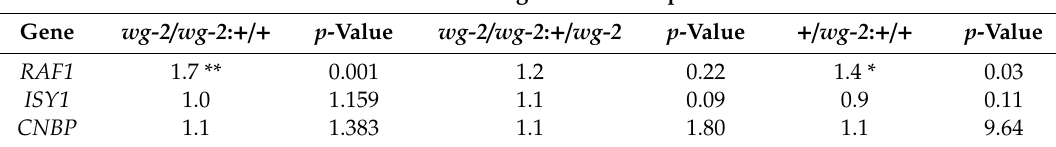
Table 4. Comparison among wg-2 genotypes of transcript expression for three genes in the linked 227-kb wg-2 region as determined by RT-qPCR indicates higher RAF1 transcript expression in mutant and carriers versus wild-type embryos. Three embryos per genotype ( n = 9 total) were analyzed for each gene and their expression compared to GAPDH at Stage 36 HH to determine the relative expression of target gene to housekeeping gene. Note that RAB43, EFCC1 / CCDC48 , and CECR5 / HDHD5 , also within the linked region, showed no transcript expression at this stage. Fold change in expression was assessed using the ddCt method [34], and per-plate PCR e ffi ciency (range of 1.52–1.66) was included in each calculation. The p -values were calculated using a two-tailed t -test with a Bonferroni correction for multiple comparisons